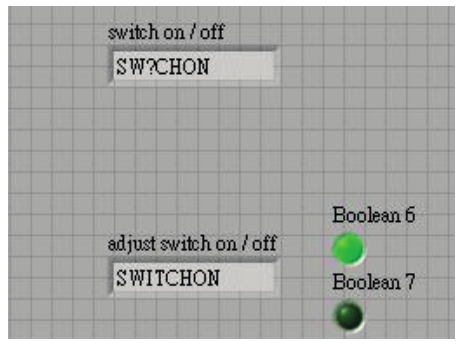
Figure 19. Original recognition result (missing letters: “I” and “T”).